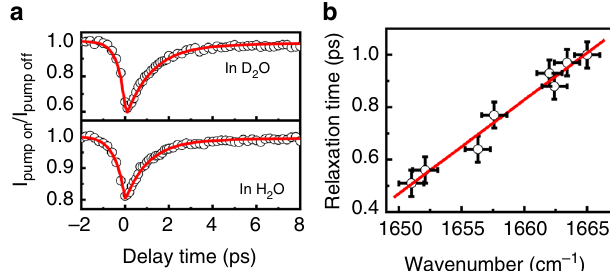
Fig. 2 Intensity decay of amide I band and relationship between relaxation time and amide I frequency. a The intensity decay of the amide I band of KALP23 at lipid membrane/water interface with ν pump = ν probe = 1660 cm − 1 . The red lines are the fi tting curves. The data for delay time at t ≤ 0.1 ps was fi tted using the function of 1 − A 0 exp( t / T 0 ) while the data for delay time at t ≥ 0.1 ps were fi tted using Supplementary Eq. 16. b Relaxation time of amide I mode against the amide I frequency. The vertical error bars represent the estimated accuracy of the fi t based on the time resolution of the laser pulse width. The horizontal error bars indicate the standard error of the mean of the fi tting center frequency from fi ve independent spectra NATURE COMMUNICATIONS| (2019) 10:1010